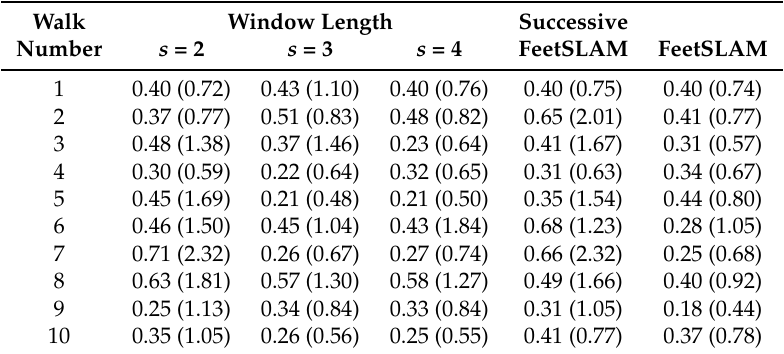
Table 2. Mean position error ¯ e and maximum error e max of 10 different walks with 6 sensors mounted on the foot for partly successive FeetSLAM for different windows lengths, successive FeetSLAM, and pure FeetSLAM computed over the whole walk. The number of iterations was 3. The maximum error is depicted in brackets.